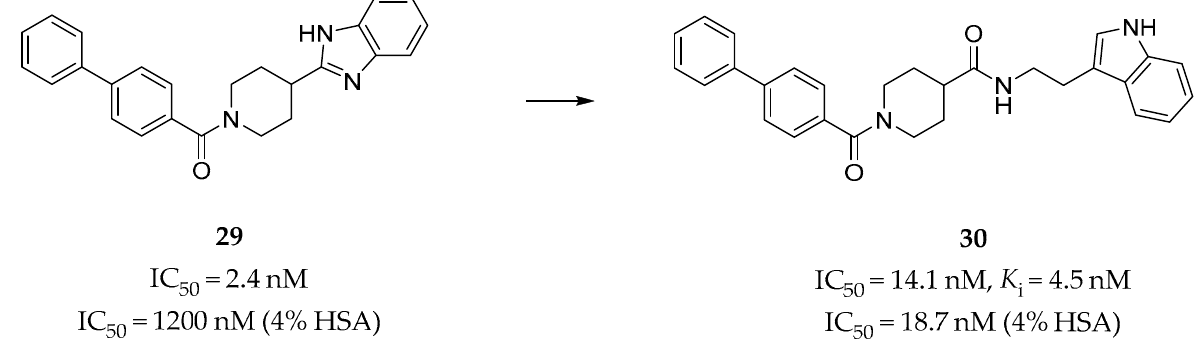
Figure 8. Representative C4 phenyl aporphines ( 27 ) and tris-(phenylalkyl)amines ( 28 ) as 5-HT 2B R antagonists [142,143].